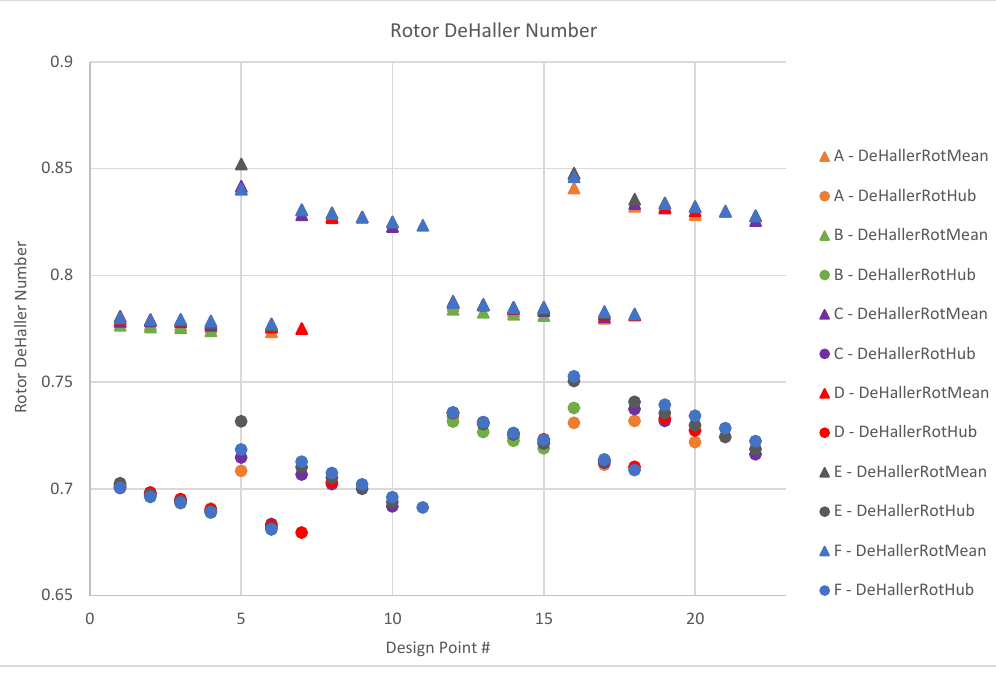
Figure 19. Variations in the rotor DeHaller with the different rotor blade parameters.